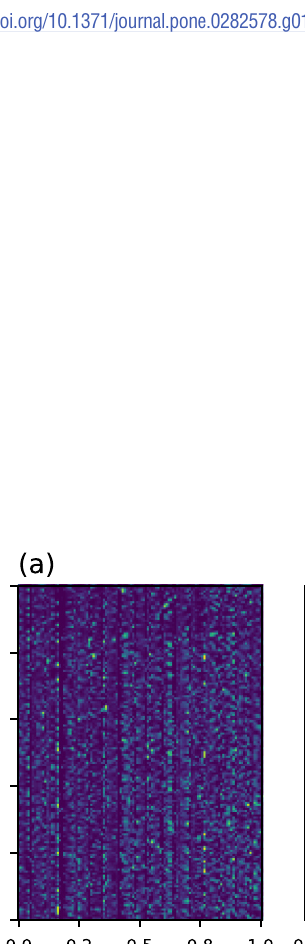
Fig 12. Acoustic impedance model recovered for an observed data contaminated with white noise (SNR = 80) and spike noise (0.5%) using objective function (a) conventional (b) Re´nyi with η = 0.3334; (c) Tsallis with q = 2.9999; and (d) Kaniadakis with κ = 0.6666.